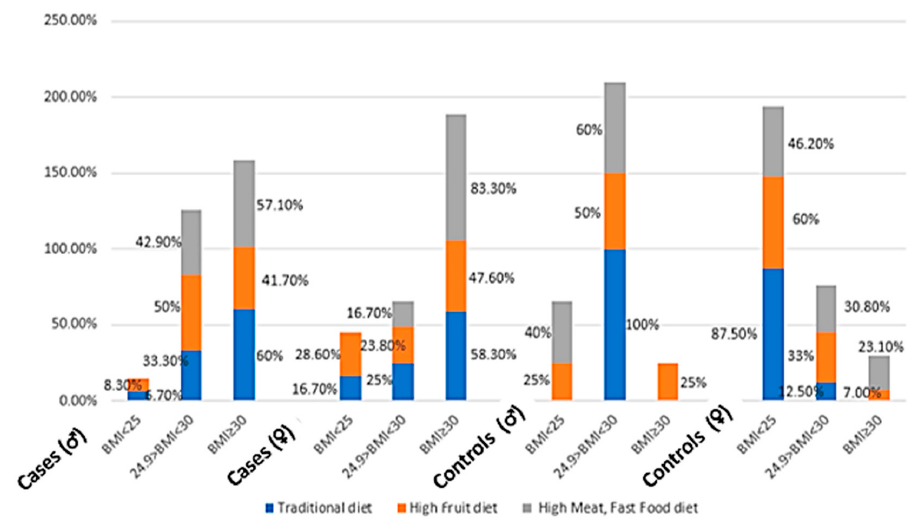
Figure 2. Distribution of participants according to the different dietary patterns.